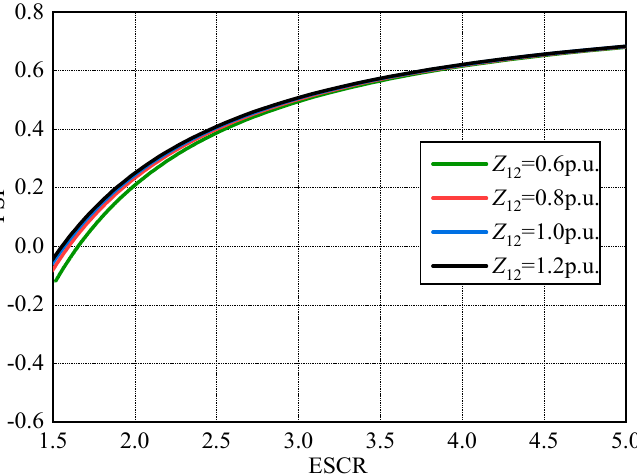
Figure 9. Curves of PSI versus ESCR for different Z 12 under VSC-HVDC constant AC voltage control mode.